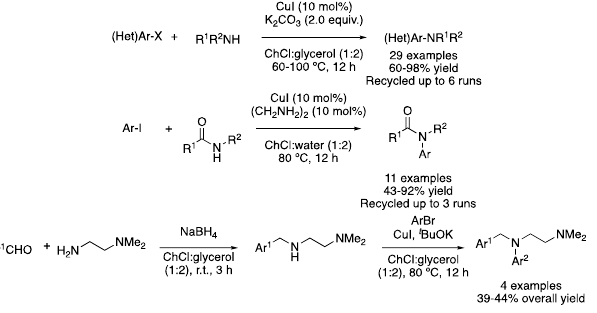
Figure 27. C-N cross-coupling reactions.